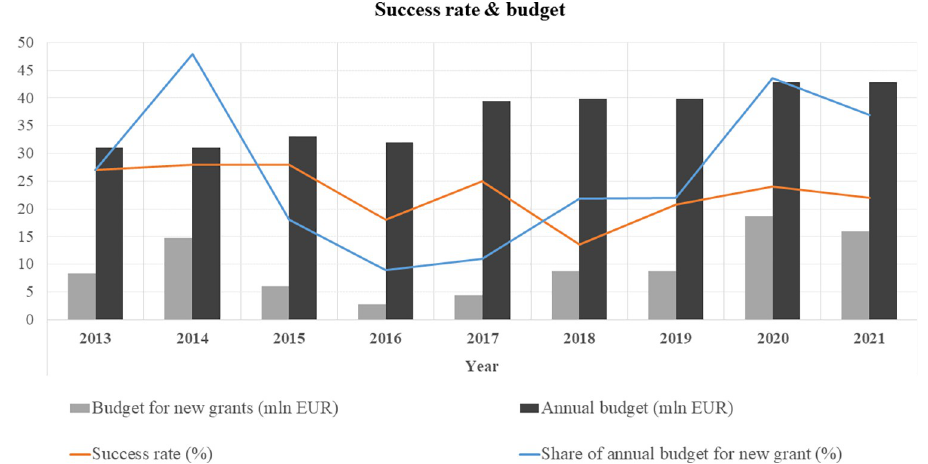
Fig 3. The importance of timing in applying for the grant: Success rate and annual budget available for new grants. Percentage values shows the success rate in the given year.